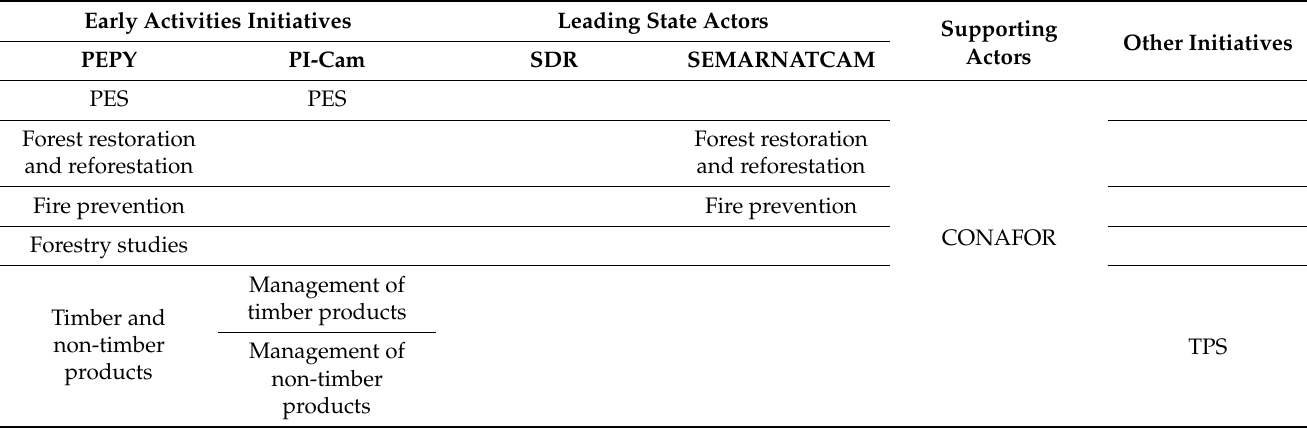
Table 2. The state government REDD+ related programs and activities and IRE-aligned initiatives in Campeche. Early Activities